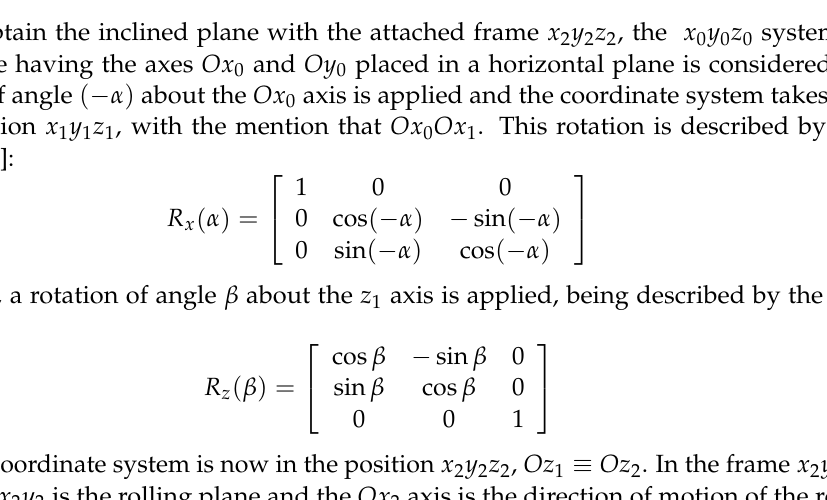
Figure 5. Finding the position of the center of mass G from the free body diagram of the rotor. To obtain the inclined plane with the attached frame 𝑥 2 𝑦 2 𝑧 2 , the 𝑥 0 𝑦 0 𝑧 0 system of coordinate having the axes 𝑂𝑥 0 and 𝑂𝑦 0 placed in a horizontal plane is considered. A